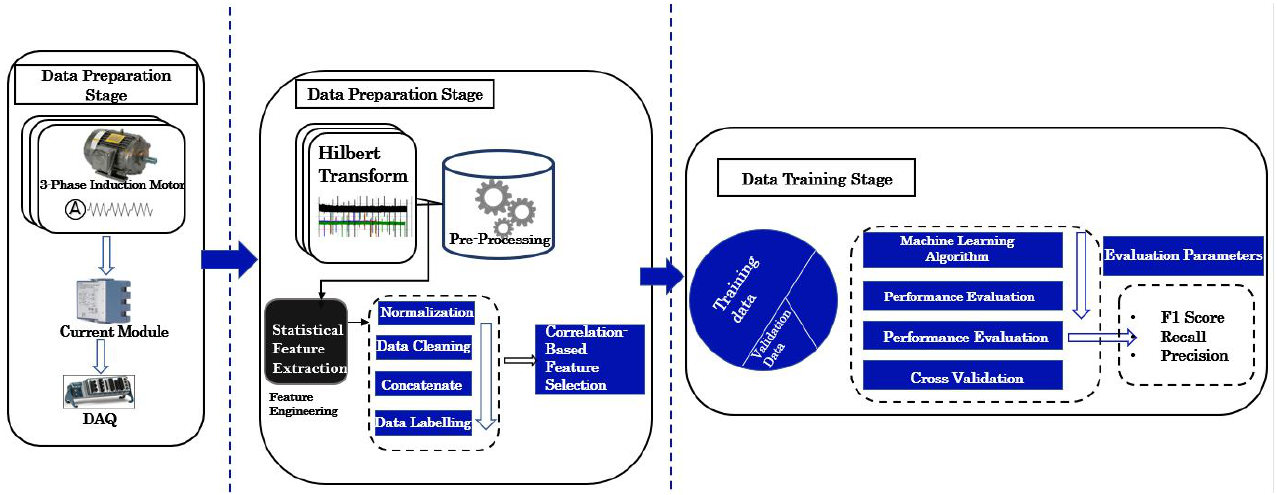
Figure 3. The proposed diagnostic